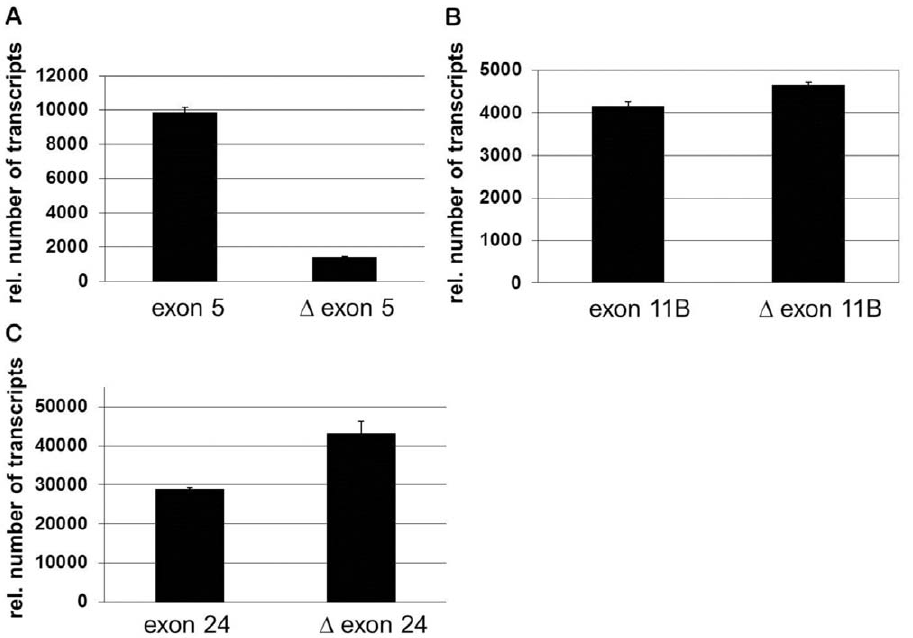
Figure 2. Real-time PCR analysis of BAT3 exons 5, 11B and 24. MelJuSo cells were subjected to RNA isolation and cDNA synthesis. BAT3 sequences were amplified by real-time PCR with specific oligonucleotides and examined for the presence of an exon (primers amplify DNA within the exon sequence) and for the absence of an exon (primers bind to exon boundaries). The presence or absence of exon 5 ( A ), exon 11B ( B ) and exon 24 ( C ) is shown as relative numbers of transcripts. Data are means 6 SD of 5